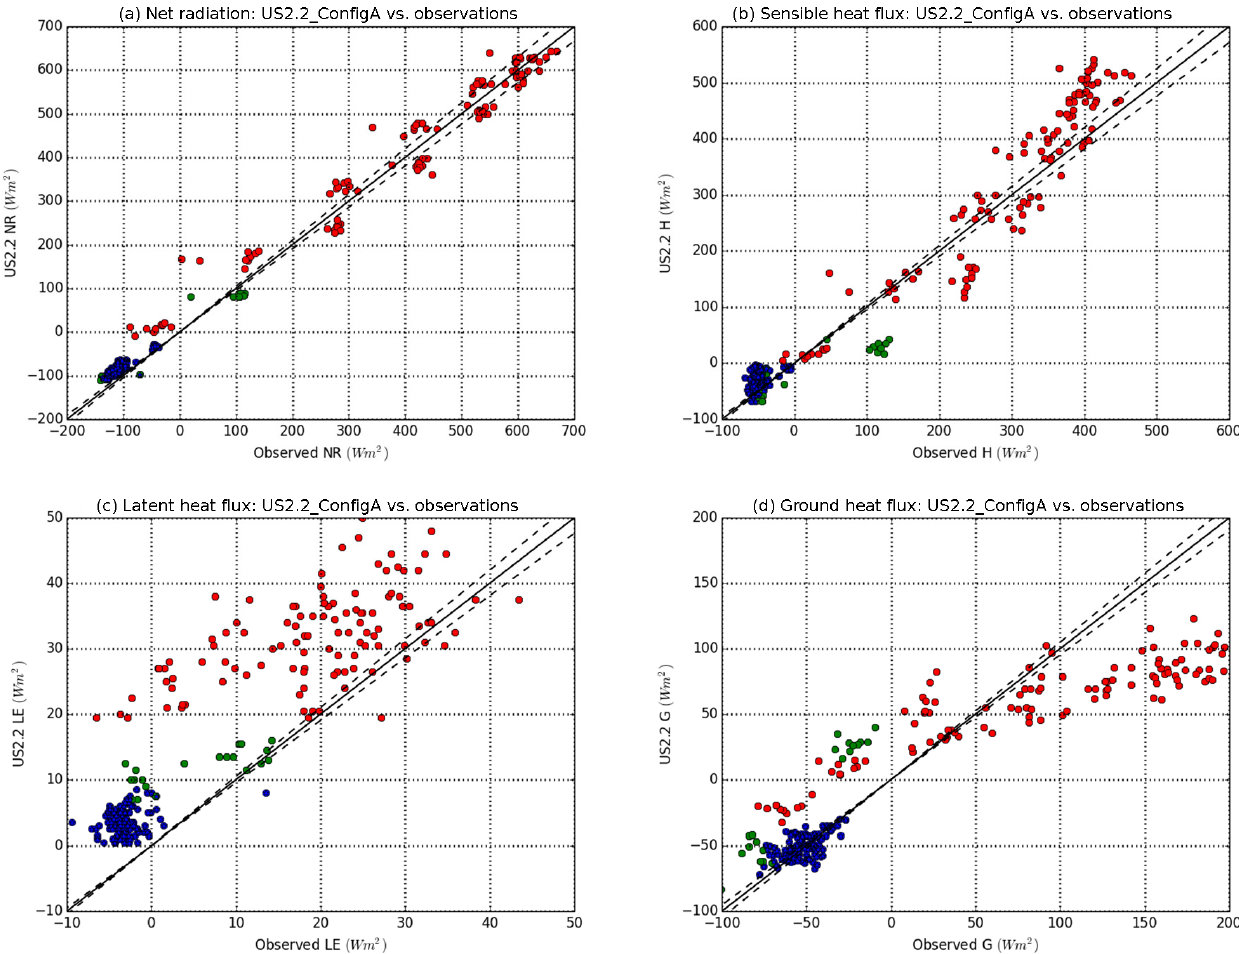
Figure 7. Scatterplots comparing the observed components of the surface energy balance with the modelled US2.2_ConfigA components of the surface energy balance at Kendall Grassland for May 2013. The panels from top to bottom are (a) net radiation, (b) (corrected) sensible heat flux, (c) (corrected) latent heat flux and (d) (measured) ground heat flux. The components of the SEB are separated into (blue) night-time (model SWD < 5Wm − 2 ), (green) transition (model SWD 5–200Wm − 2 ) and (red) daytime (model SWD > 200Wm − 2